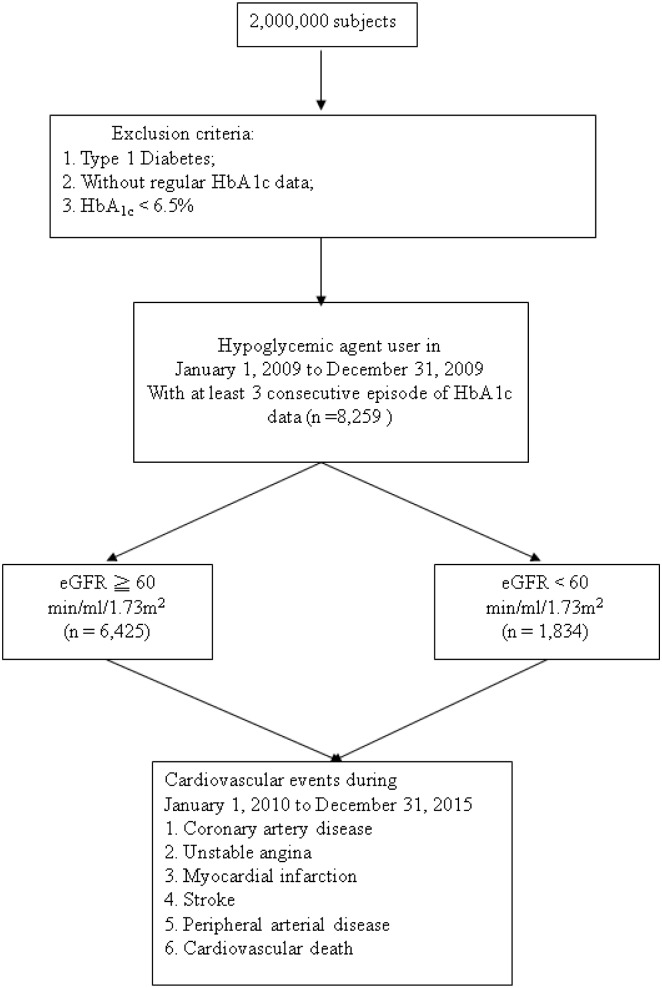
Flow chart of study participants for the study to evaluate the effect of SD of HbA1c on cardiovascular events in type 2 diabetes.